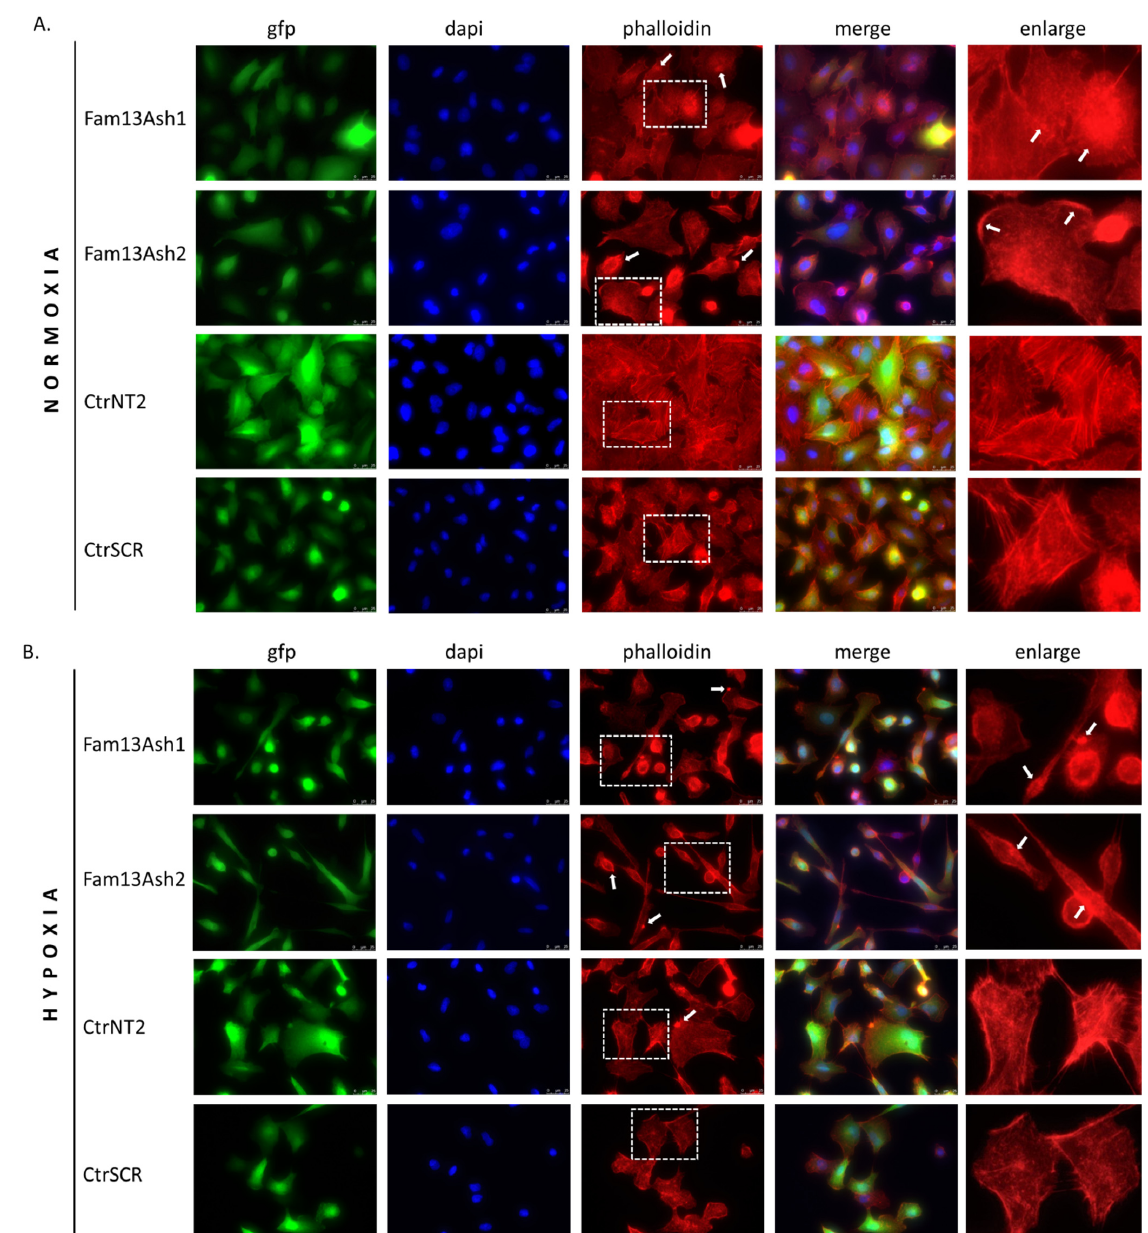
Figure 6. Stable knockdown of FAM13A promotes F-actin cytoskeletal reorganization. The FAM13A depleted cells (FAM13Ash1, FAM13Ash2) and control (CtrSCR, CtrNT2) cells, were cultured under normoxia and hypoxia for 72 h. After incubation, the cells were fixed, permeabilized and stained with Alexa Fluor ® 568 phalloidin for actin filaments visualization and DAPI for nuclei. The cells were observed under a fluorescence microscope. Example images (scale bar 25 μ m) of the diverse F-actin organization phenotypes induced by FAM13A gene silencing in normoxia ( A ) and chronic hypoxia ( B ). A549 cells with stable FAM13A knockdown (gfp positive) were stained with phalloidin for F-actin (red), with DAPI for nuclei (blue). Representative single and overlaid images of immunofluorescence staining were present (magnification, ×63). The arrowheads indicate F-actin aggregates and accumulations of F-actin punctae.